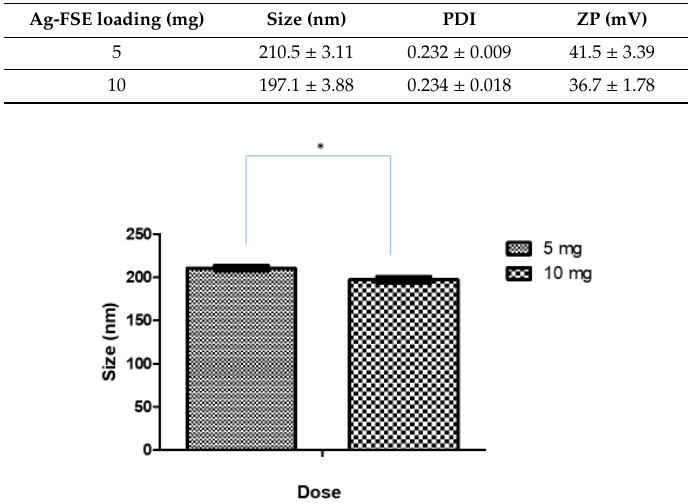
Figure 3. Effect of drug loading on size of CSNPs; *significant difference between 5 mg and 10 mg loading (p < 0.05).